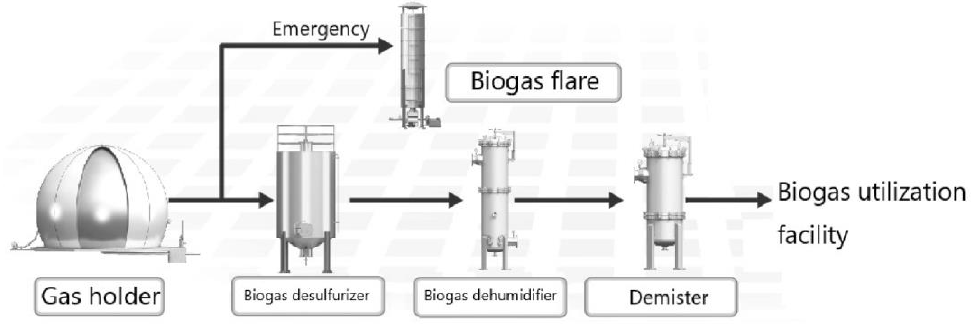
Figure 6. Biogas refinery system. From reference